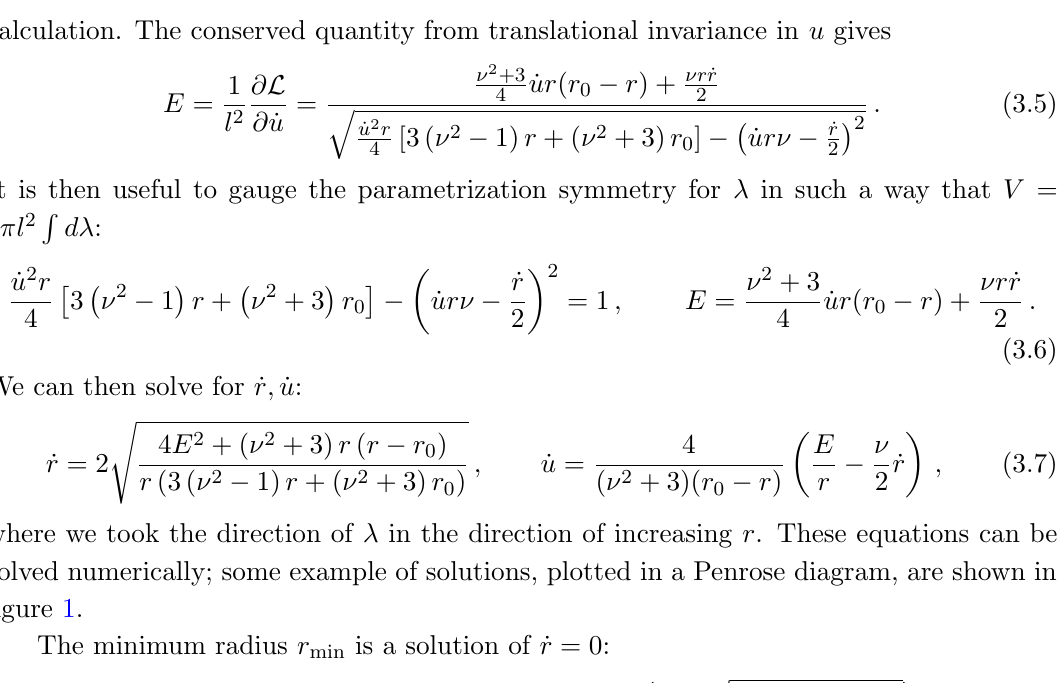
Figure 1 . Solutions to eqs. (3.7) for the non-rotating case, plotted in a Penrose diagram, for (cid:23) = 2 : 5 and r 0 = 1. The E = E 0 line, which sits at constant r min = r 0 limit. Penrose diagram coordinates from [61] have been